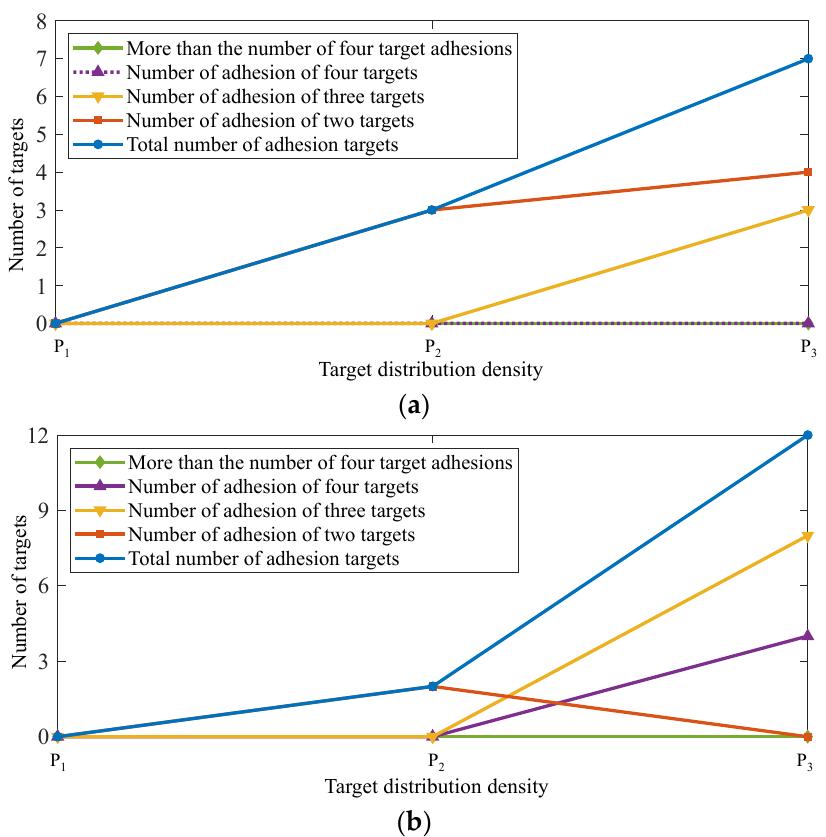
Figure 16. Accuracy of image segmentation.